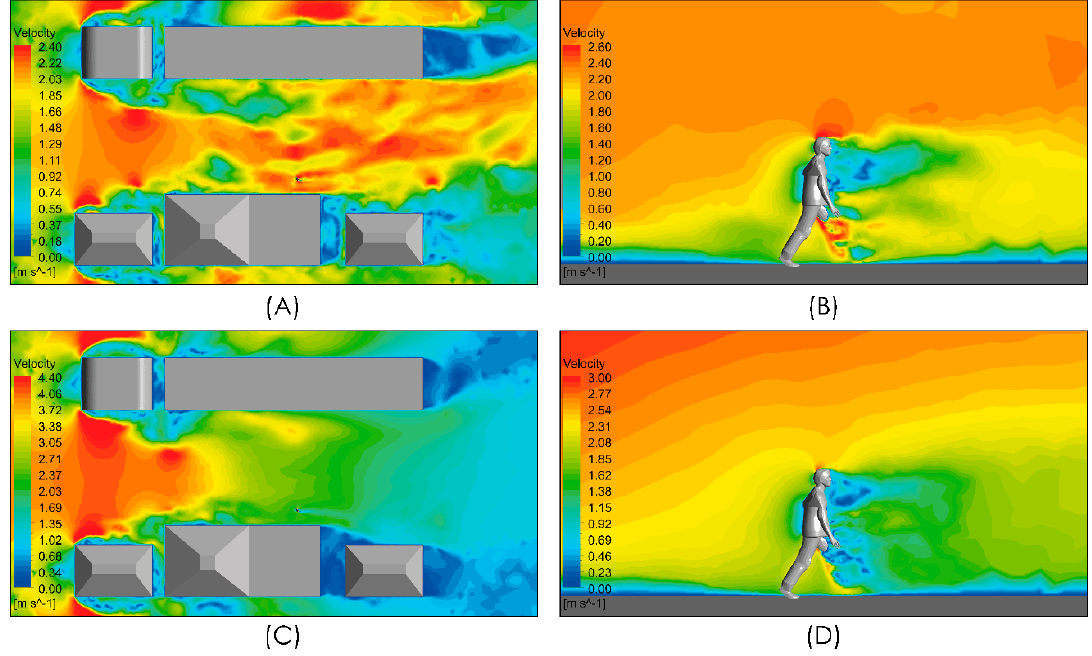
Figure 7. Distribution of air velocity magnitude. Top panels show the distribution in a horizontal plane at a 1m height and in a vertical plane close to the person. Moderate intensity airflow of 2 m/s ( A , B ) and intense airflow of 4 m/s ( C , D ).